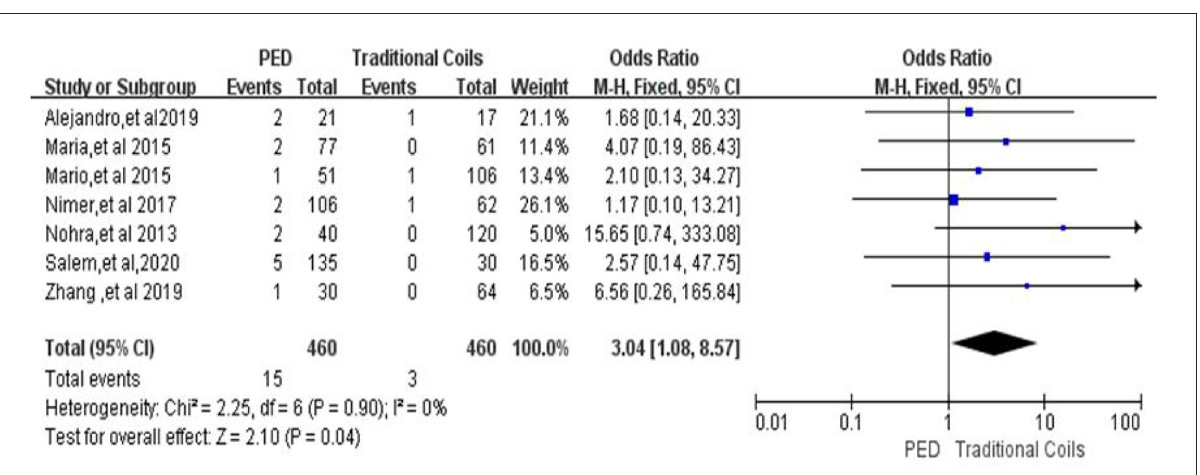
lower ( I 2 = 40%, p = 0.1), with complete occlusion rates of